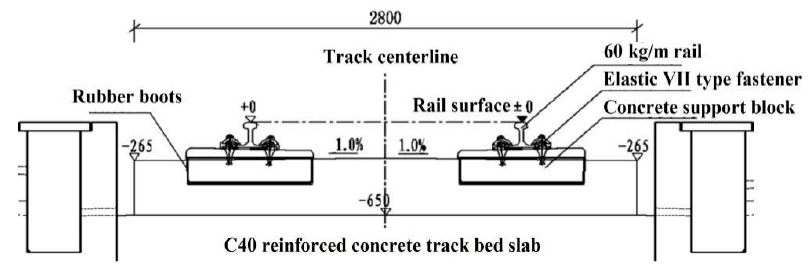
Figure 5. Cross-sectional view of LVT in the tunnel.